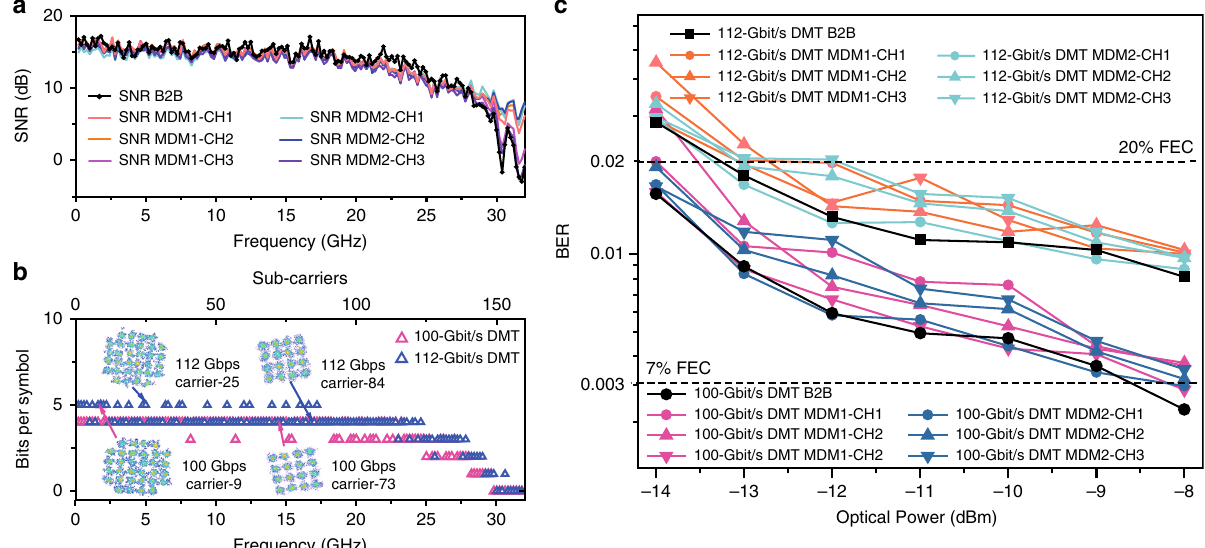
Fig. 7 Experimental results of the high-speed signal routing in mode-division multiplexing (MDM) circuits. a The signal-to-noise ratio response for back-to- back (B2B) and MDM circuits transmission. b The bit allocation for different subcarriers. Inset: constellations of different subcarriers. c Measured bit error rate curves for the B2B and MDM transmission of 100 and 112 Gbit/s discrete